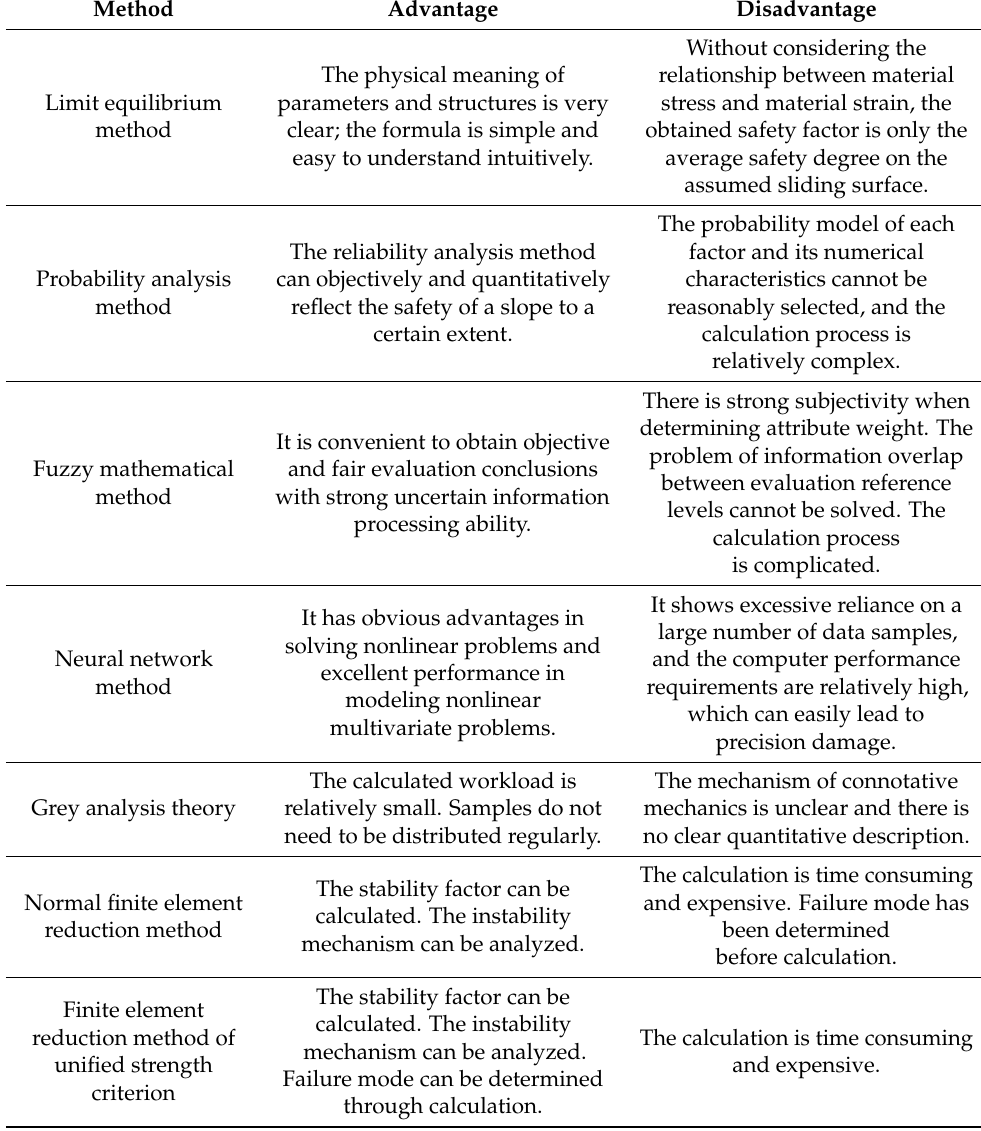
Table 1. Method for analysis of slope